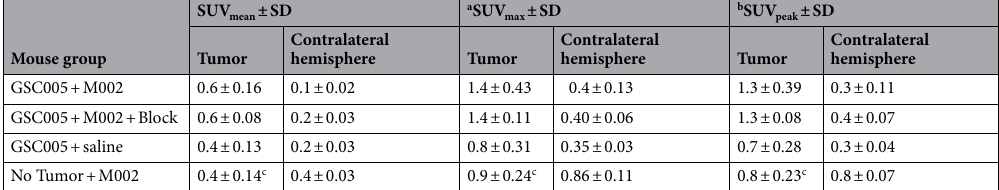
Table 1. In vivo PET SUV results 24 h after injection of [ 89 Zr]-malDFO-169 cDb. a Single voxel containing the maximum SUV value in the ROI. b Average SUV of the 3 × 3 × 3 voxel grid containing the SUV max voxel. c Activity determined in the right brain hemisphere around the region of injection, rather than tumor region in the “No Tumor + M002” group of